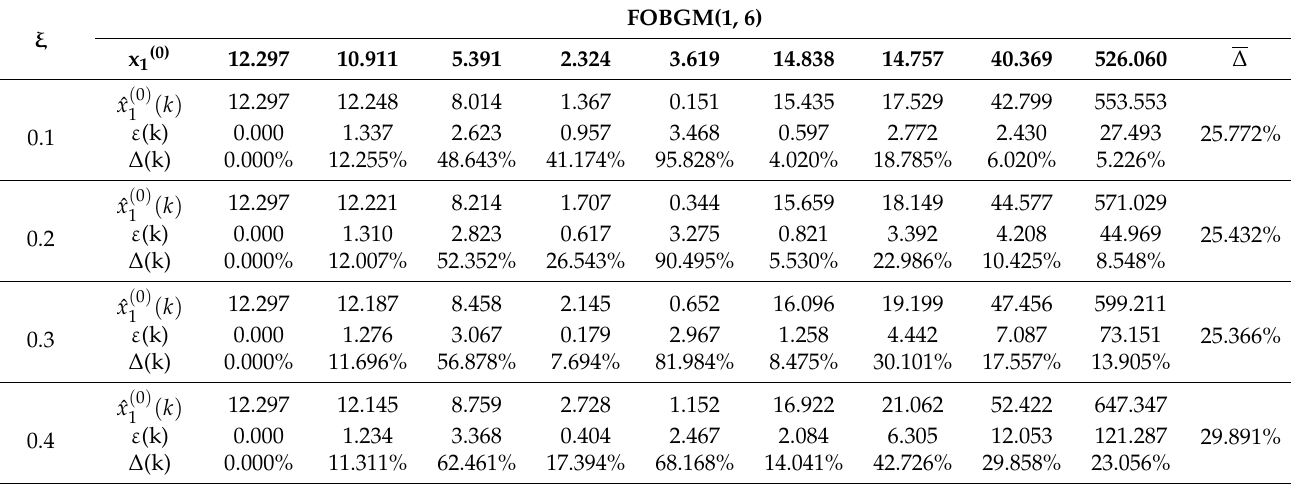
Table 1. Fitting effect of FOBGM with different background